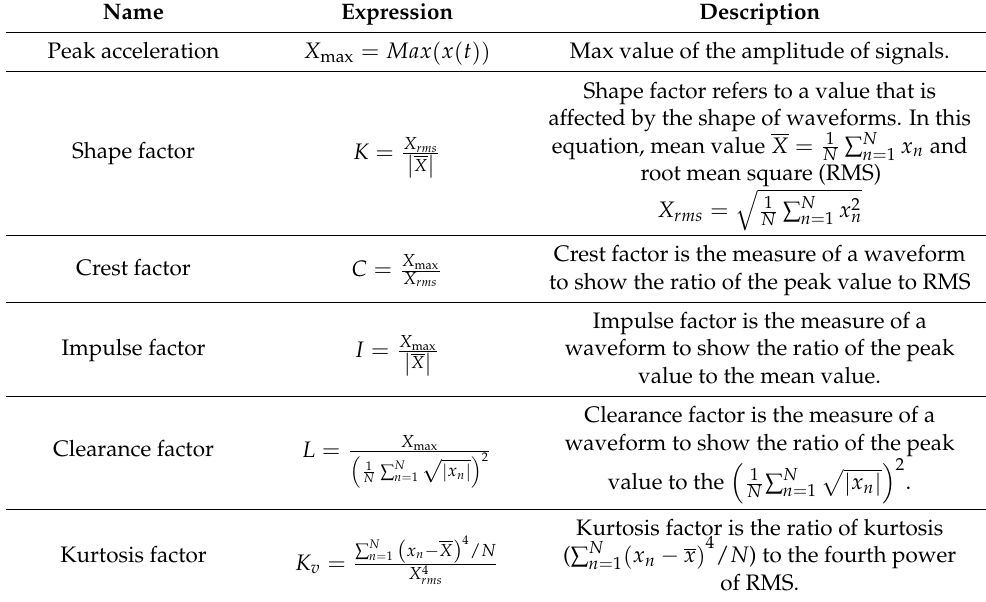
Table 1. Summary of time-domain